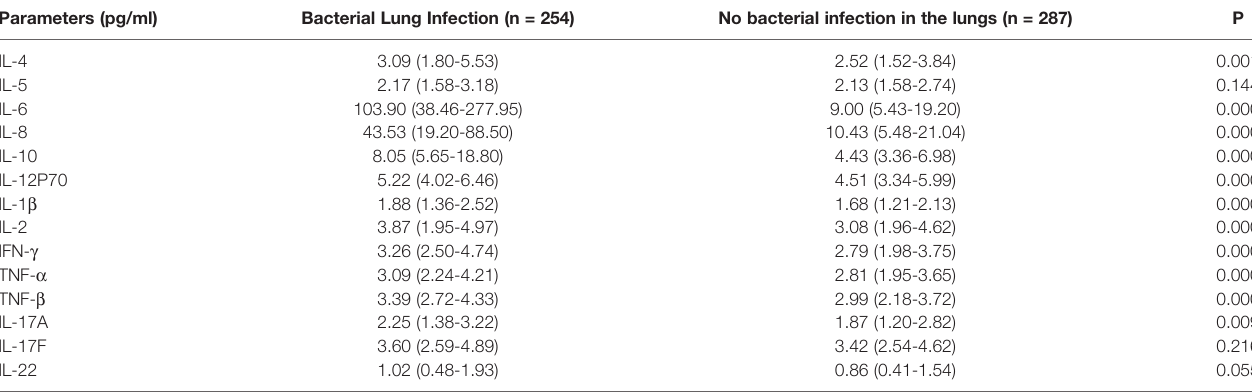
TABLE 2 | Analysis of the difference between infected and uninfected. Parameters (pg/ml) Bacterial Lung Infection (n = 254)